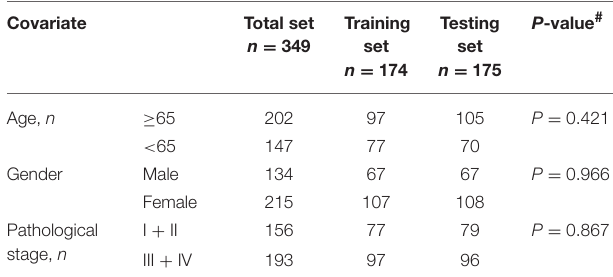
TABLE 1 | Clinical covariates for included